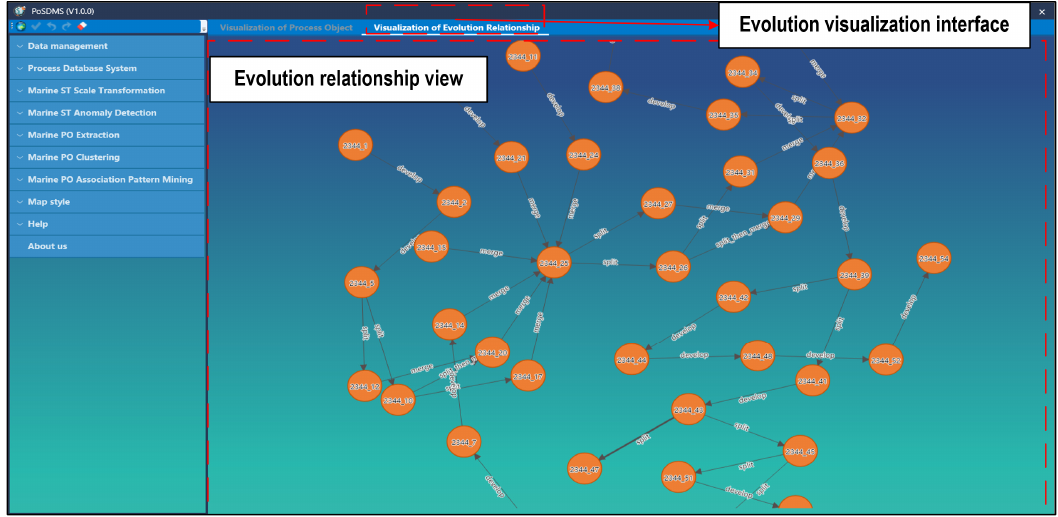
Figure 12. Evolutionary relationship of a specified process object of SSTA.